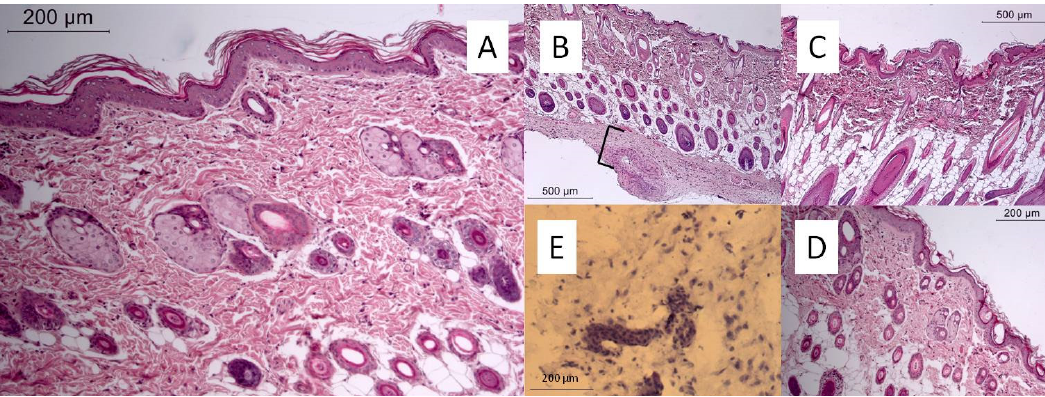
Figure 6. Microphotographs of tissue slices surrounding implants derived from the ( A ) Ti–25Nb–13Ta–5Zr alloy (bar size 200 μ m, 14 days after surgery), ( B ) Ti–25Nb–13Ta–5Zr alloy (bar size 500 μ m, 60 days after surgery; the bracket denotes the connective tissue capsule), ( C ) Ti (bar size 500 μ m, 14 days after surgery), ( D ) NiTi (bar size 500 μ m, 14 days after surgery) and ( E ) Ni (bar size 500 μ m, 14 days after surgery).